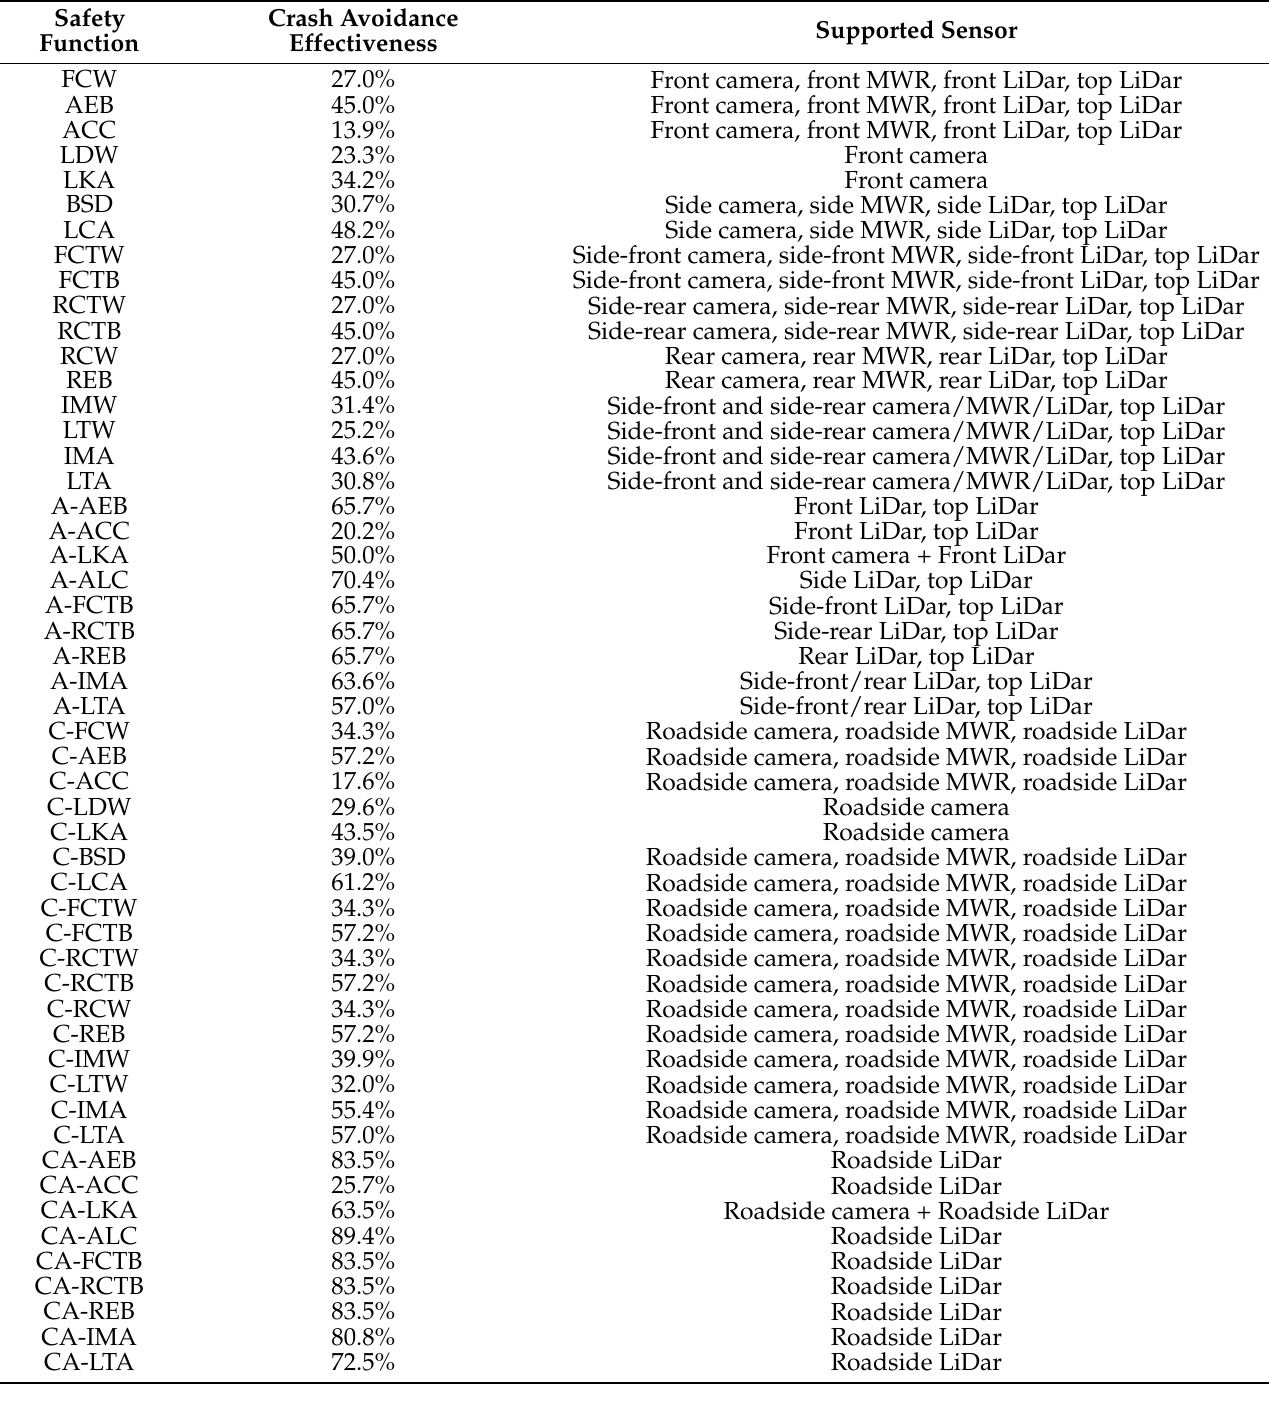
Table 2. Crash avoidance effectiveness of safety